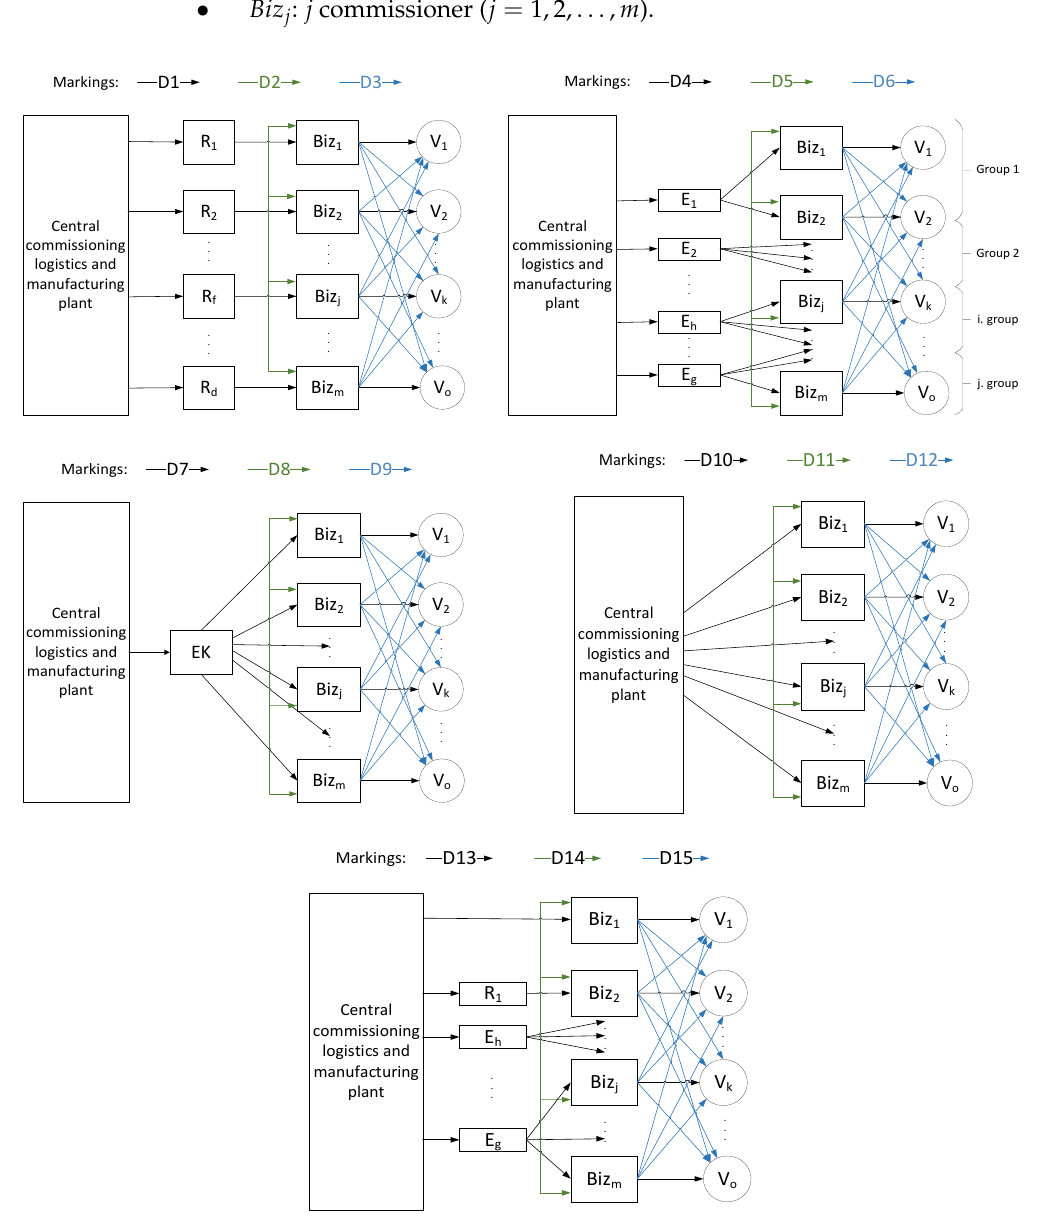
Figure 4. Distribution model variants (Source: Self-Edit). Figure 4 shows three types of arrows. Black arrows represent the material flow of the base model, while other supplemented versions of which are marked with blue and green arrows. In addition, an integrated version of all types can be